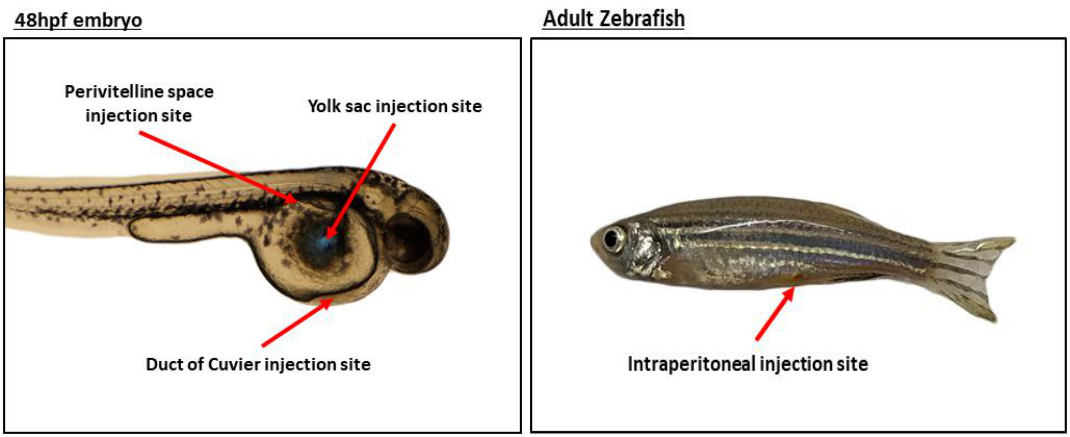
Figure 1. Representative image of the main injection sites.